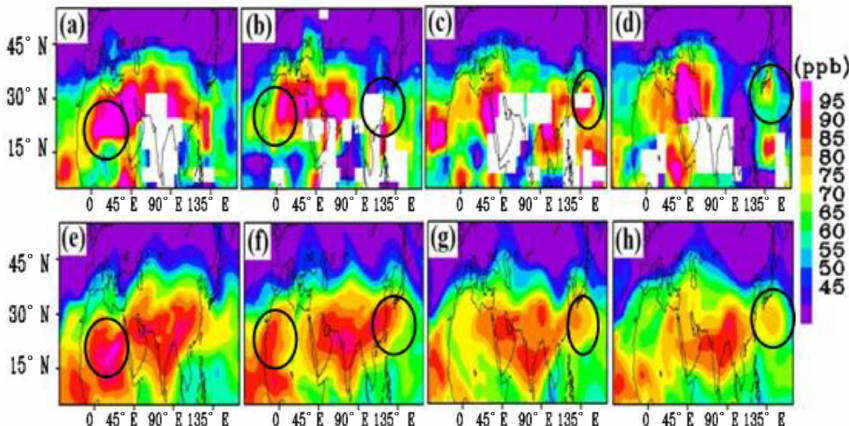
Figure 5. Spatial distribution of CO mixing ratios (ppb) at 16km: MIPAS satellite observations for (a) 1–2 July, (b) 3–4 July, (c) 5–6 July, (d) 7–8 July 2003 and ECHAM5-HAMMOZ CTRL simulations for (e) 2 July, (f) 4 July, (g) 6 July and (h) 8 July 2003. Maximum amounts of CO near the location of eddies are shown with black